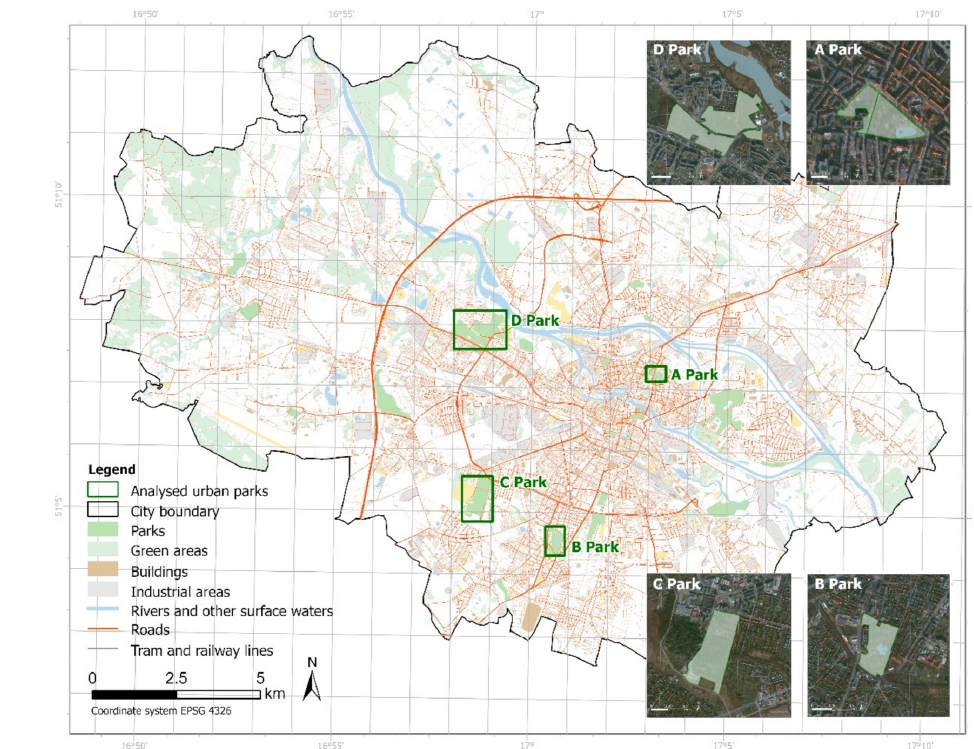
Figure 2. Location of urban parks and built-up area in Wroclaw. Green rectangles indicate case study